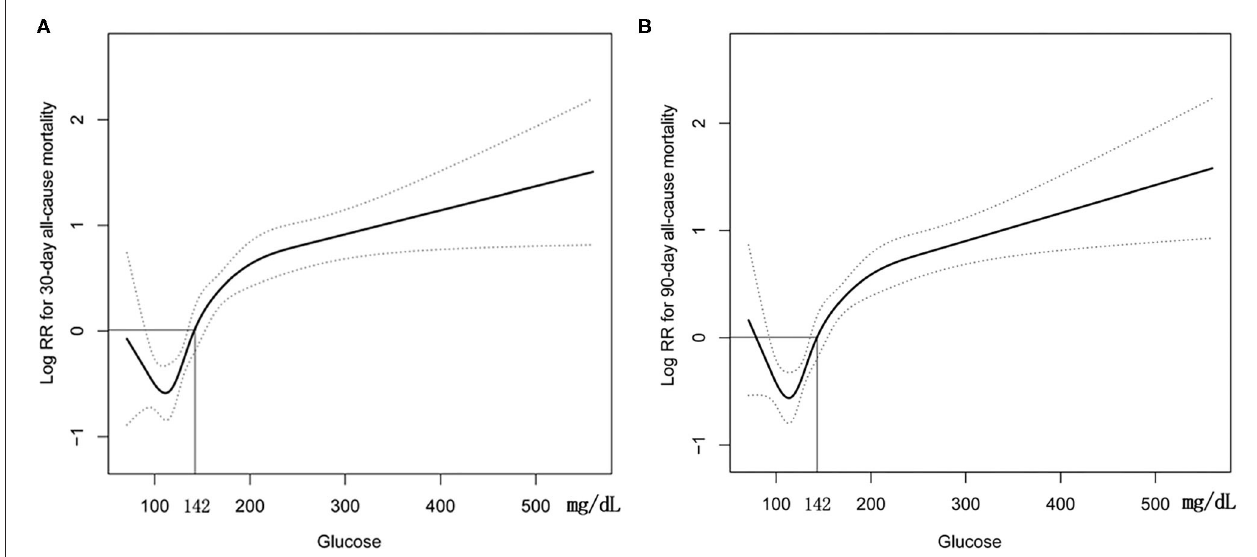
FIGURE 2 | Construction of smooth curve describing the risk of mortality against admission BG using a generalized additive model. (A) 30-day all-cause mortality; (B) 90-day all-cause mortality. Dashed curves present the 95% confidence interval.